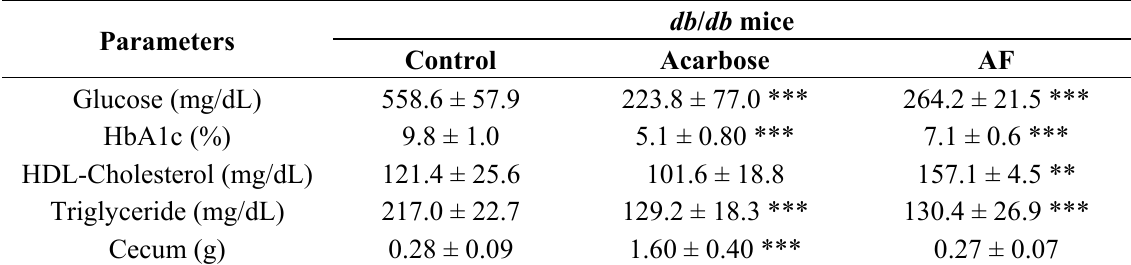
Table 1. Effect of AF and acarbose treatment on various parameters in db / db